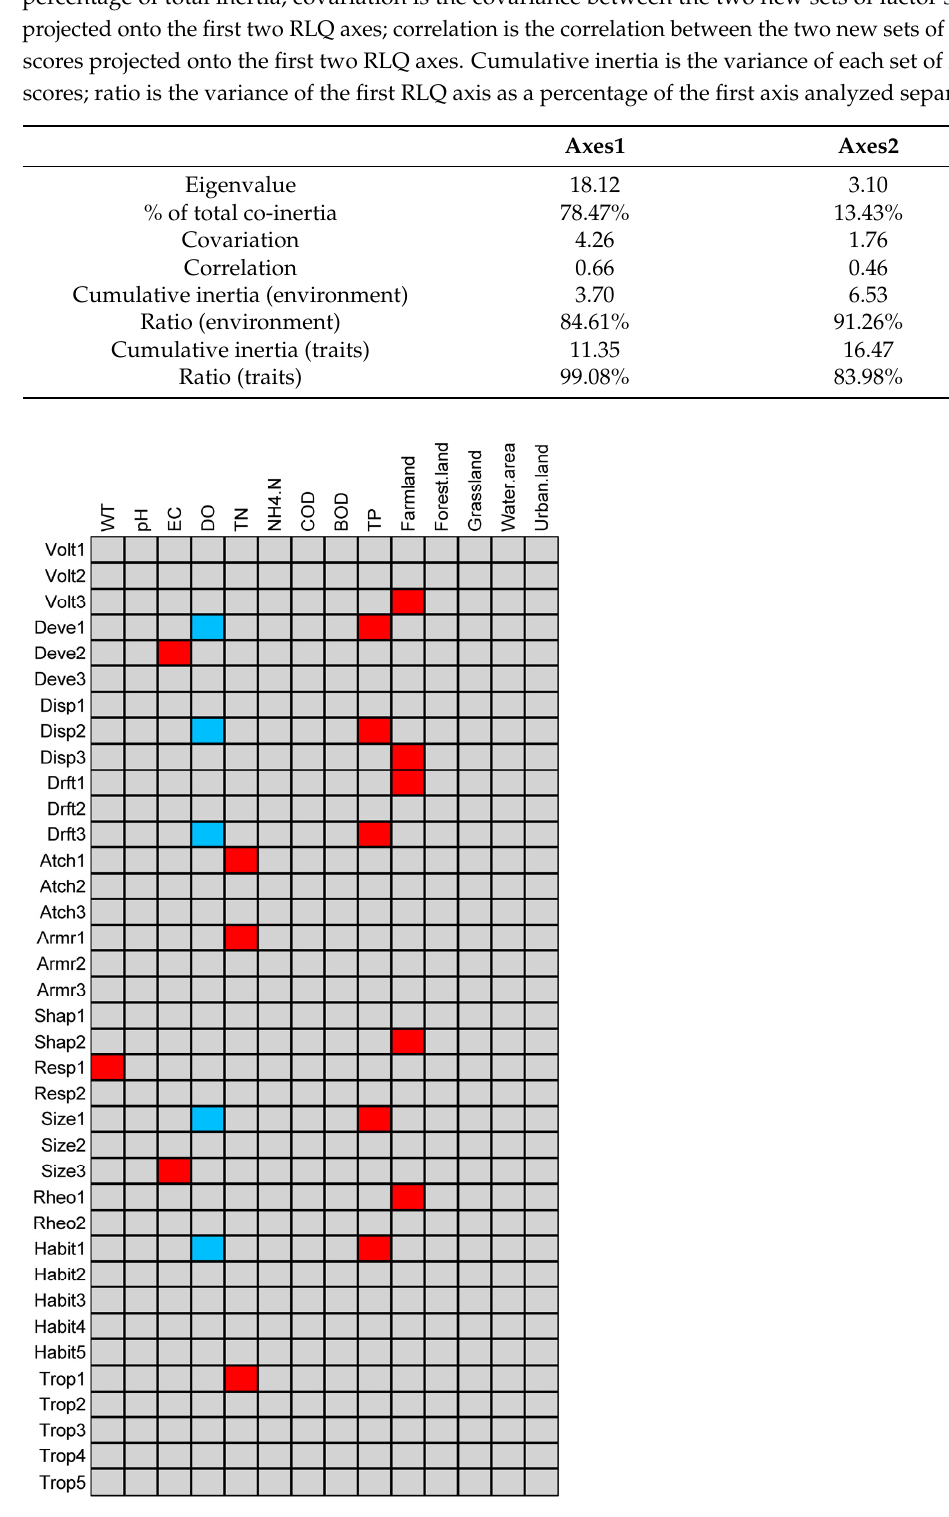
Figure 5. The summary of combining RLQ and fourth-corner analysis for macroinvertebrates traits and environmental variables. Red/blue cells indicate significant positive/negative relationships, respectively; grey cells indicate no significant relationships. The codes for macroinvertebrate traits and environmental variables are explained by Tables 1 and 2, respectively.